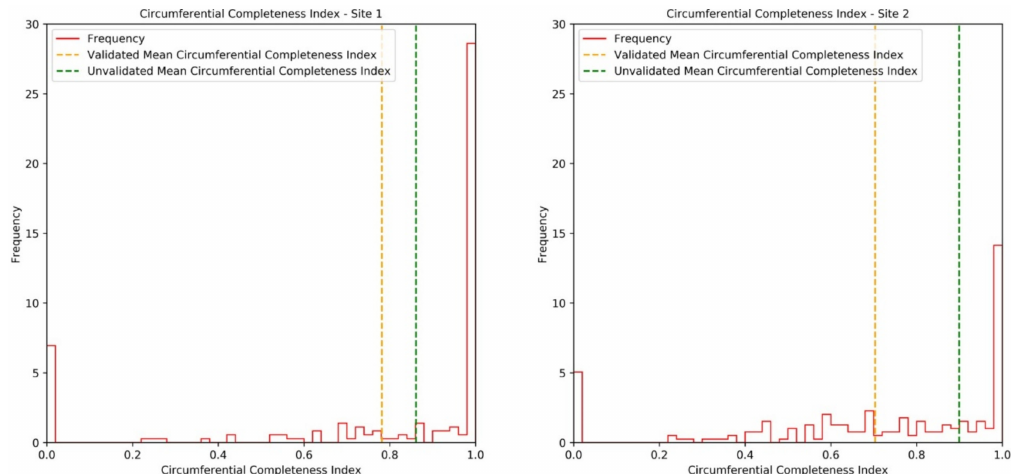
Figure 13. Histograms showing Circumferential Completeness Index (CCI) for Site 1 ( Left ) and Site 2 ( Right ). Measurements with a completeness score of 0 are measurements which were not su ffi ciently well captured in the point cloud to extract a clear stem circle. Measurements with CCI of 1 were those with a fully reconstructed stem circle.